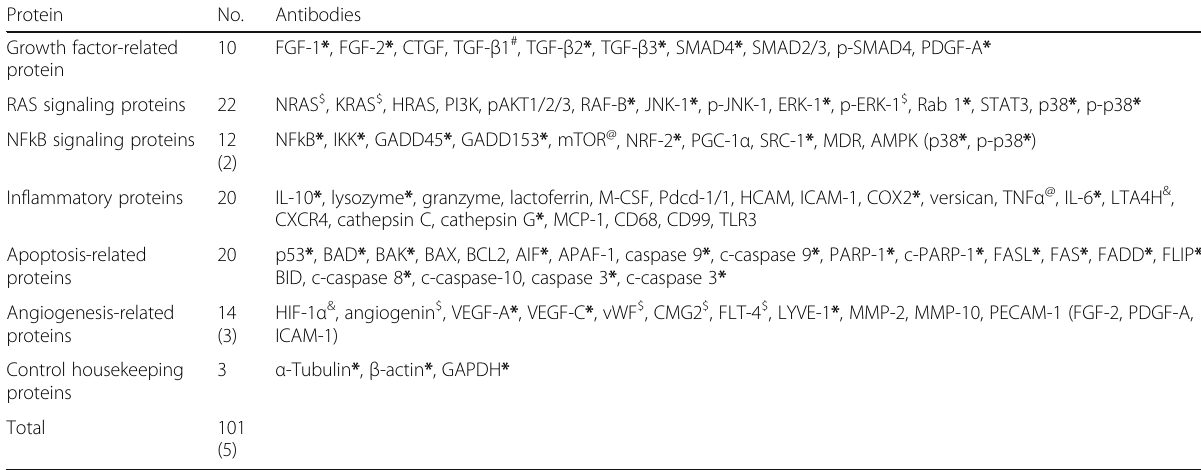
Table 1 Antibodies used in the study Protein No. Antibodies Growth factor-related